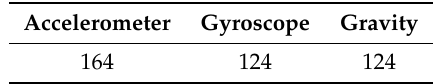
Figure 1. Main screen of the data collection application, before and after recording data. Table 2. Average number of sensor readings per 10-s